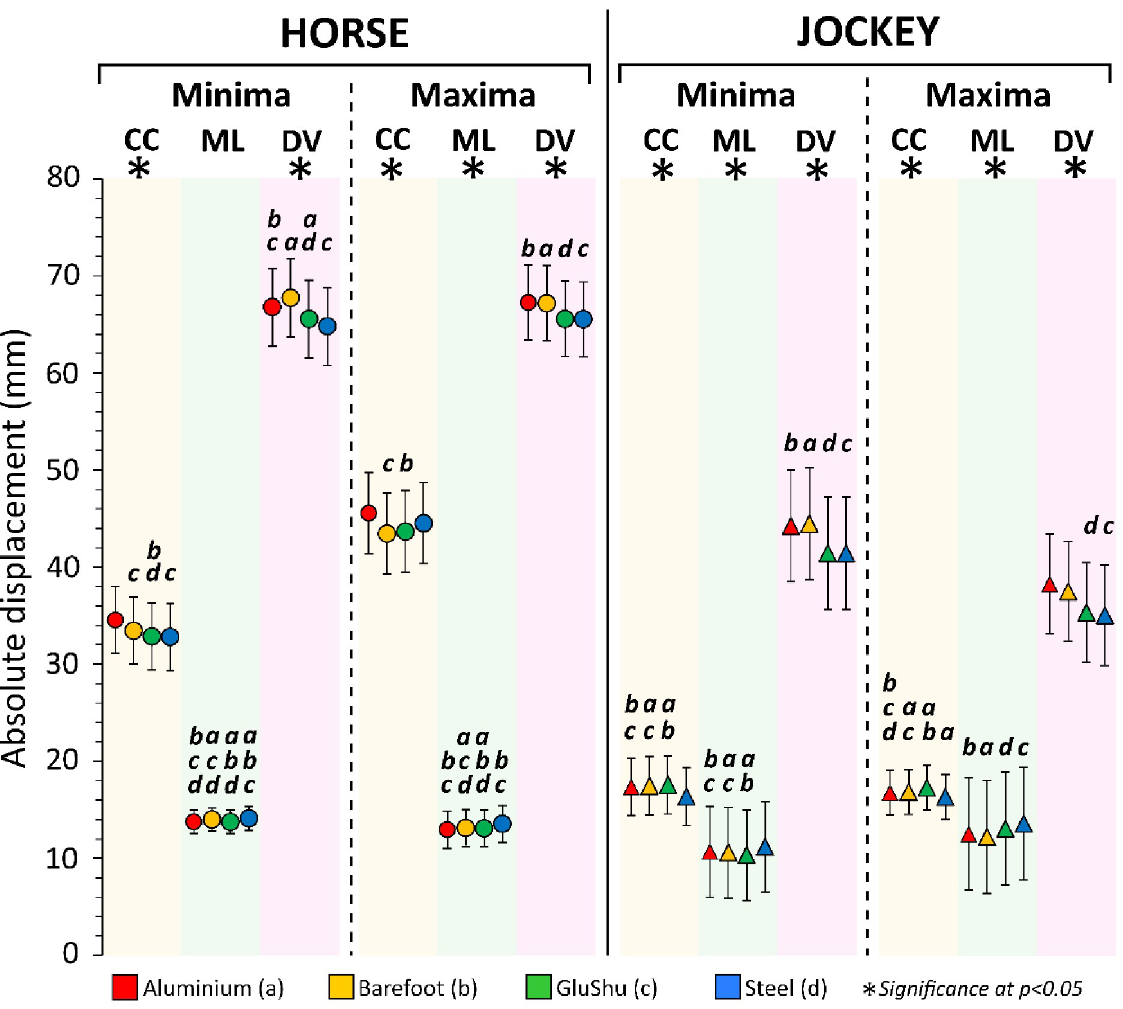
Fig 10. Output of linear mixed models for shoe effects. Estimated marginal means with 95% confidence interval are presented per displacement parameter. Significant differences between shoeing conditions detected in post-hoc tests (with Bonferroni correction) are indicated. CC = cranio-caudal, ML = medio-lateral, DV =